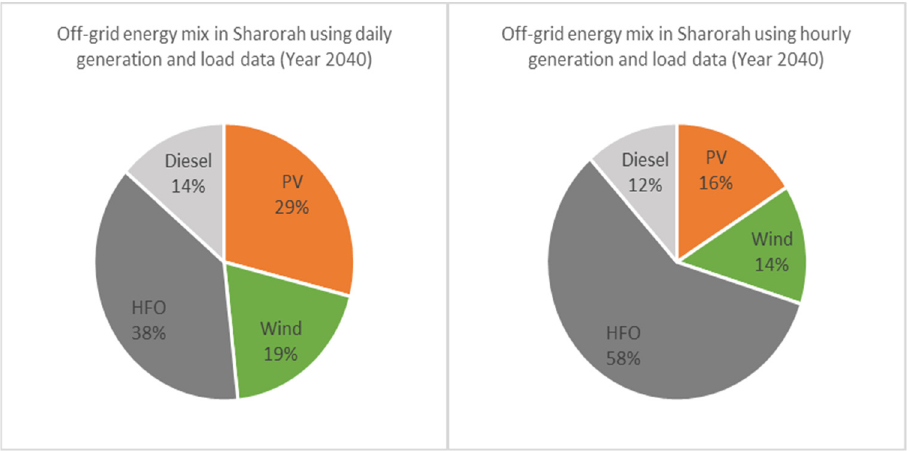
Figure 2. Comparison of off-grid energy mix in Sharorah using daily versus hourly simulated generation and load data.